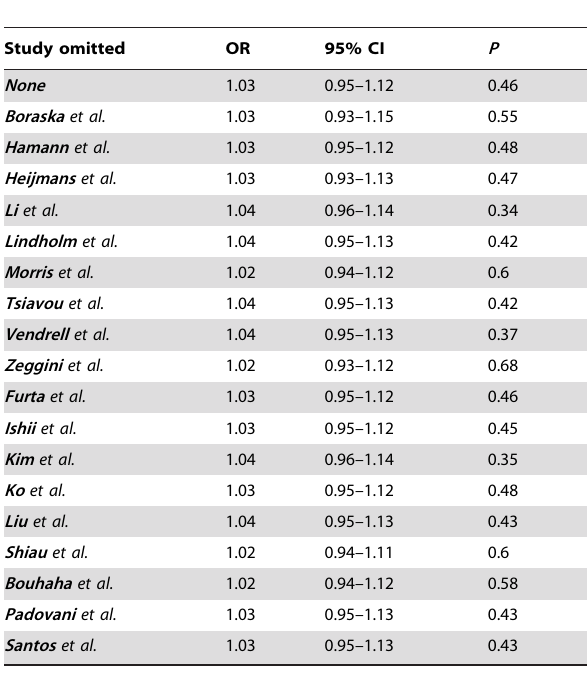
Table 2. Sensitivity analysis with each study omitted in fixed- effects model.